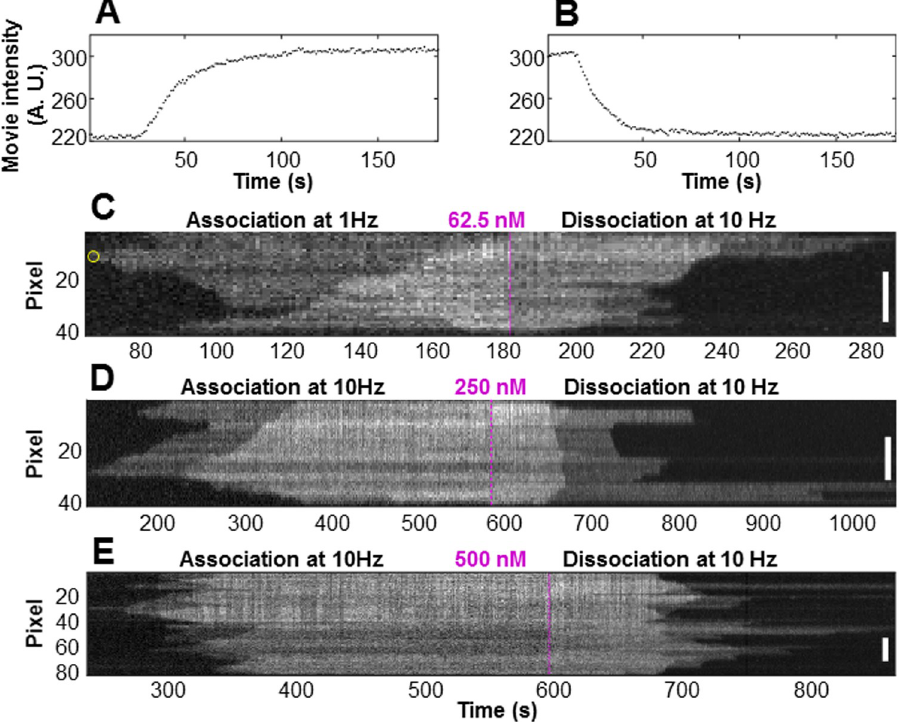
Fig 3. Intensity profile and kymographs of tropomyosin Tpm1.1 at different concentrations. (A) The total intensity of the region of interest (ROI) as a function of time during the association phase. The ROI is selected by the user in the image, and intensity thresholding is then used to define the boundaries of individual filaments. Note the rapid rise in intensity at approximately 30 seconds. The increase is due to the Tpm1.1 which was bound to the actin filament. The intensity plateaus as the entire actin filament is coated with Tpm1.1. (B) The total intensity of the ROI as a function of time during the dissociation of Tpm1.1 from the same actin filament. The intensity profiles in panels A. and B. correspond to the kymograph shown in the panel C. The tropomyosin was loaded into the microfluidics channel at (C) 62.5nM, (D) 250nM, and (E) 500nM during the association phase. After full saturation of the actin filament the channel was washed with buffer only (dissociation phase). The vertical axes of each kymograph show the length of the filament where an individual pixel represents 92nm. The frames (pixels) shown in the horizontal axis were typically recorded at 1Hz for the 62.5nM association and 10Hz at the other concentrations. The magenta dashed line shows the boundary between the association and dissociation phases. The scale bars show 20 pixels (1.84 μ m) in length. The yellow circle at approximately 64 seconds, at pixel 10 of the filament in panel C indicates the initial nucleation of binding.